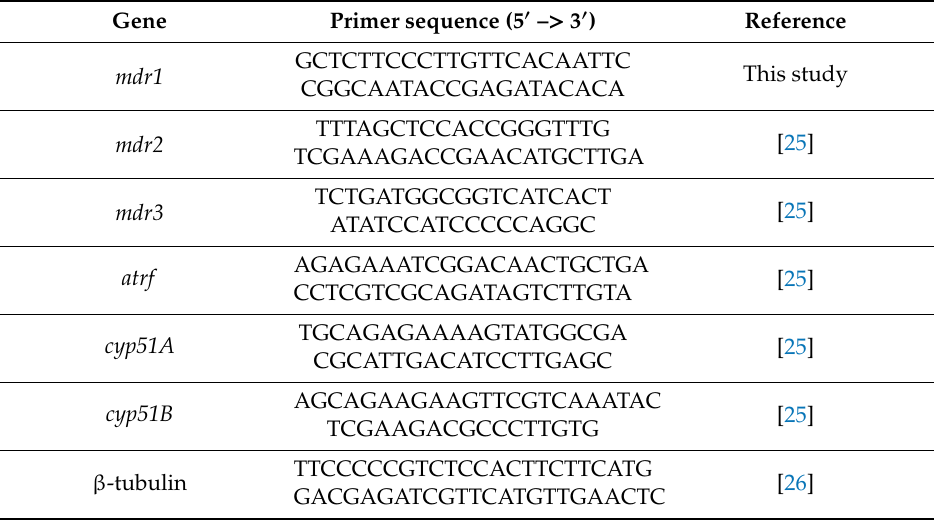
Table 2. The list of primers sequence used on this study.